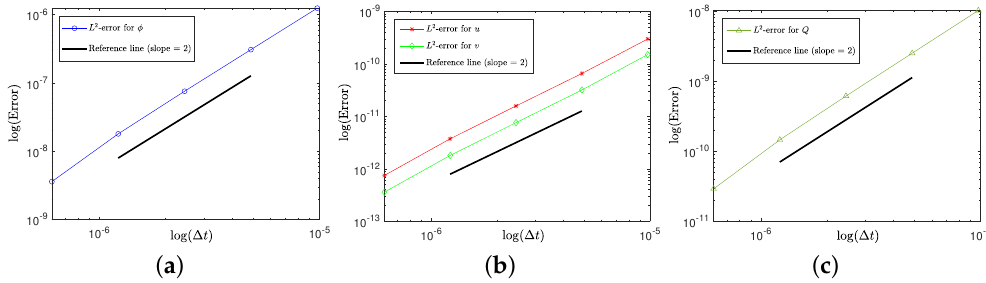
Figure 1. L 2 -errors for φ ( a ), velocities ( b ), and Q ( c ) under different time steps. Here, the log-log view is